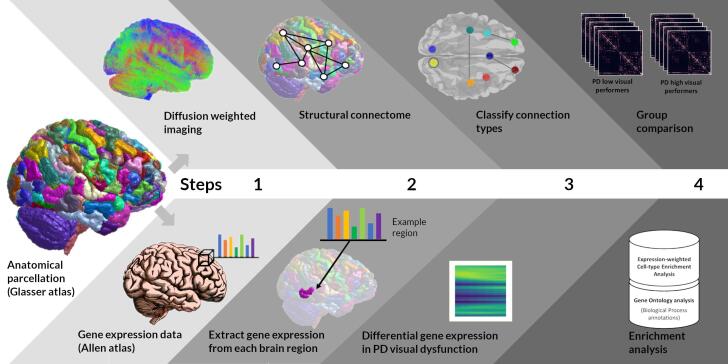
Overview of the study methodology. A1. Anatomically constrained tractography was used to determine white matter streamlines from diffusion weighted imaging (DWI) data for each participant. A2. DWI data were combined with anatomical parcellation of 379 brain regions using the Glasser atlas to generate a connectivity matrix for each participant. A3. Connection types were classified into interhemispheric (between hemispheres), intrahemispheric (within a hemisphere), intramodular (within a cortical module) and subcortial-cortical (between the subcortical regions and a cortical module). A4. Connection strength in different connection types was compared between PD low visual performers and PD high visual performers. B1. Gene expression data were extracted from the Allen Brain atlas and genes passing threshold expression were chosen. B2. Allen atlas samples were mapped into the 180 cortical regions from the left hemisphere according to the anatomical parcellation and an average cortical regional gene expression was calculated for each gene. B3. Partial least squares regression was performed for interhemispheric and basal ganglia-cortical connections in PD low visual performers. The regional gene expression in PD low visual performers associated with interhemispheric and subcortical-cortical white matter loss was calculated based on normalised gene weightings of the second PLS component. B4. Enrichment analysis was performed for the downweighted and upweighted genes that were significantly associated with connection loss for both connection types. Enrichment analysis included Gene Ontology (GO) biological processes, Expression-weighted Cell-type Enrichment analysis (EWCE) and enrichment for specific gene lists for PD, Alzheimer’s, Dementia with Lewy Bodies.